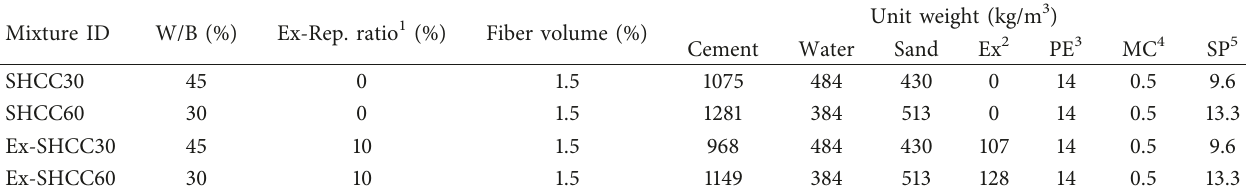
Table 1: Mix proportions of SHCC and Ex-SHCC mixtures.